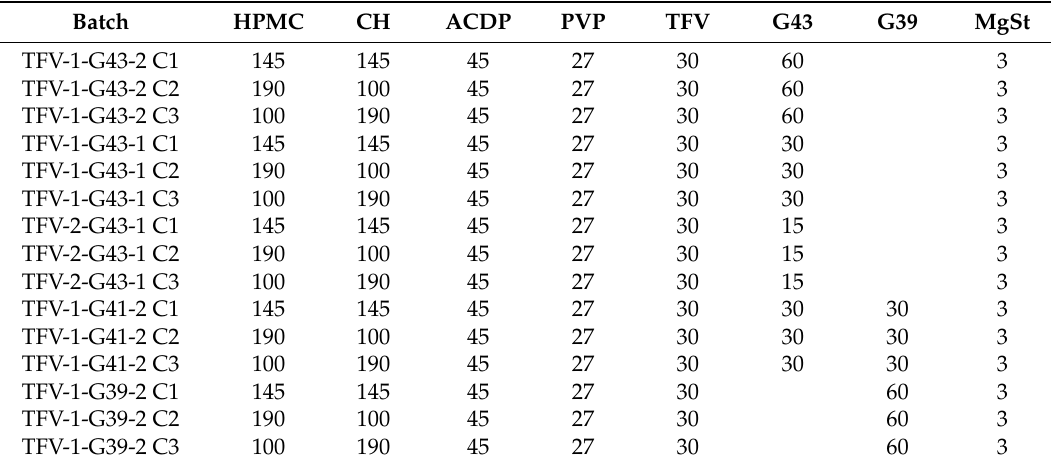
Table 2. Tablet composition